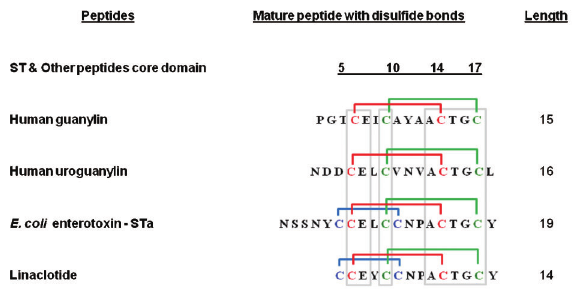
Figure 4. Primary peptide structures of human guanylin and uroguanylin, Escherichia coli heat-stable enterotoxin (STa) and linaclotide. The lines connect the disulfide bonds between the cysteine residues. Note that two disulfide bonds are formed in the active conformation of human guanylin and uroguanylin and three disulfide bonds formed the active conformation of STa enter- otoxin and linaclotide. The conservative peptide core domains with identical amino acids are marked by